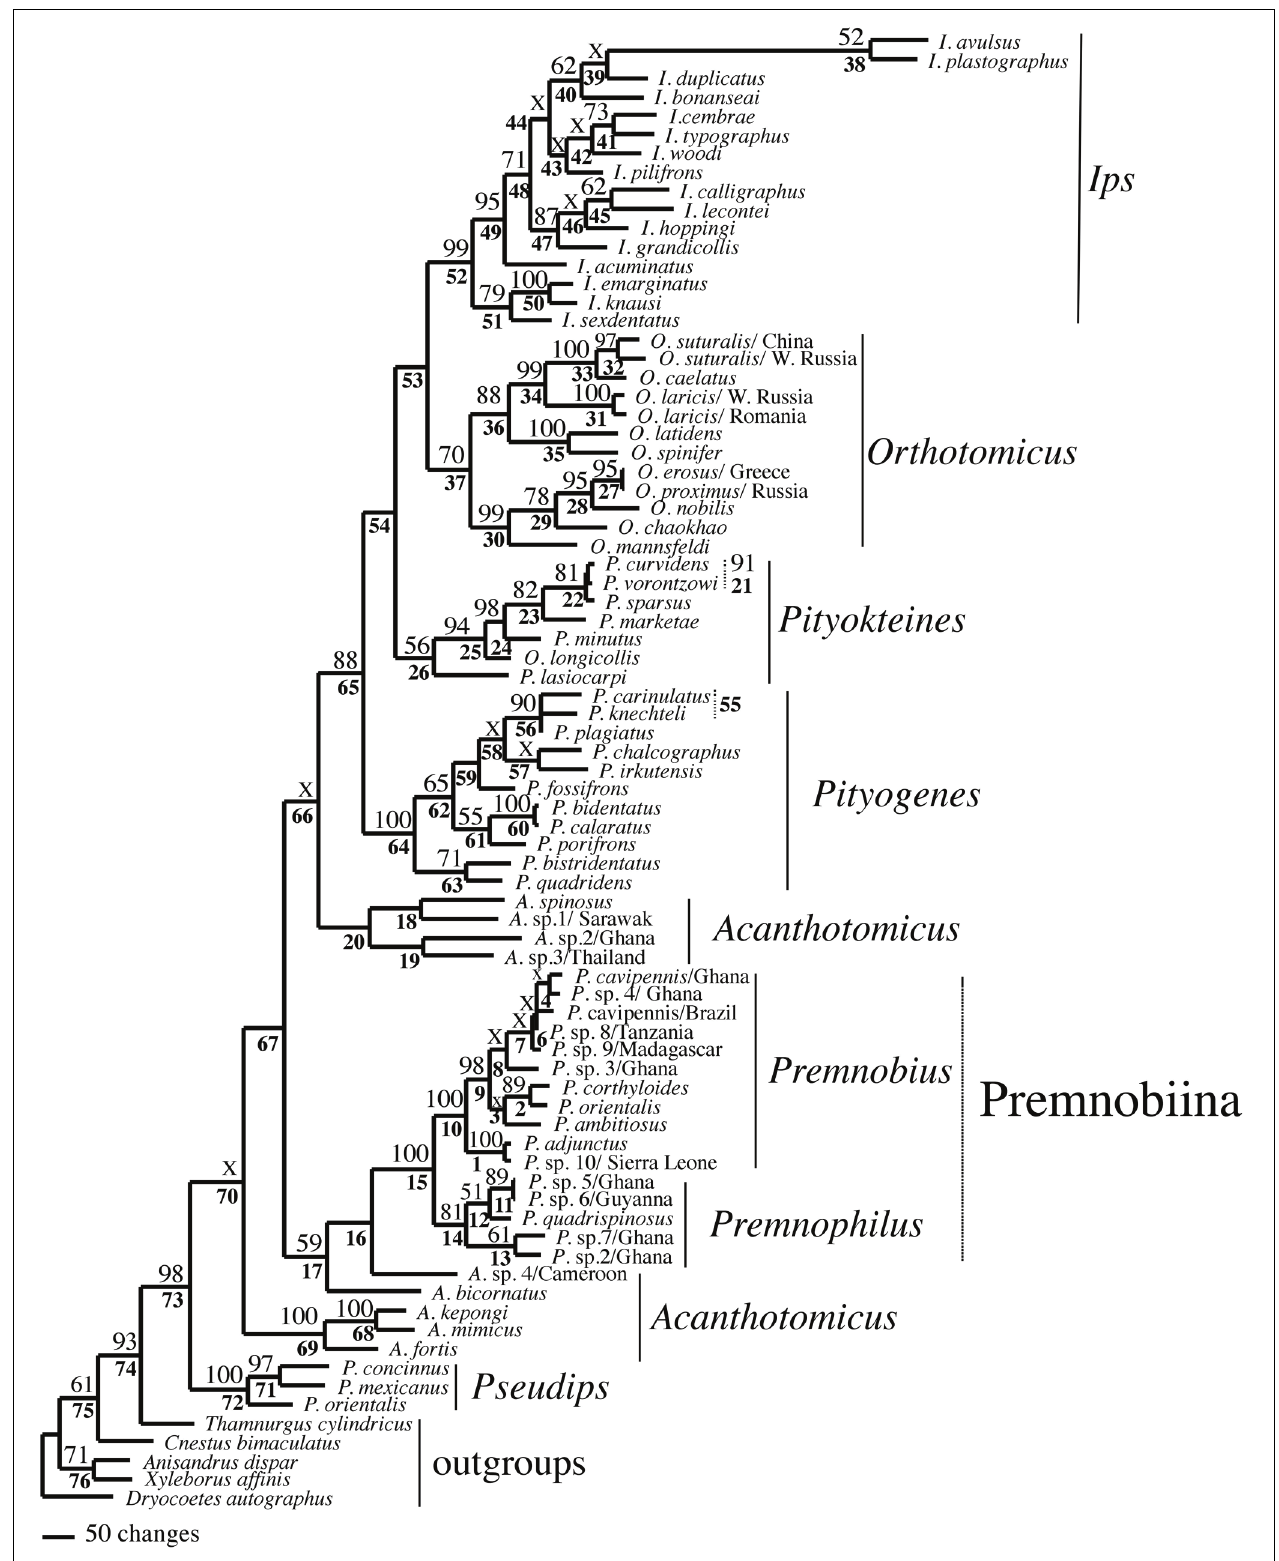
FIGURE 2 | Phylogeny of Ipini and outgroup species; 1 of 756 most parsimonious trees based on the MUSCLE aligned data. Clades marked by “X” were not resolved in the strict consensus of the